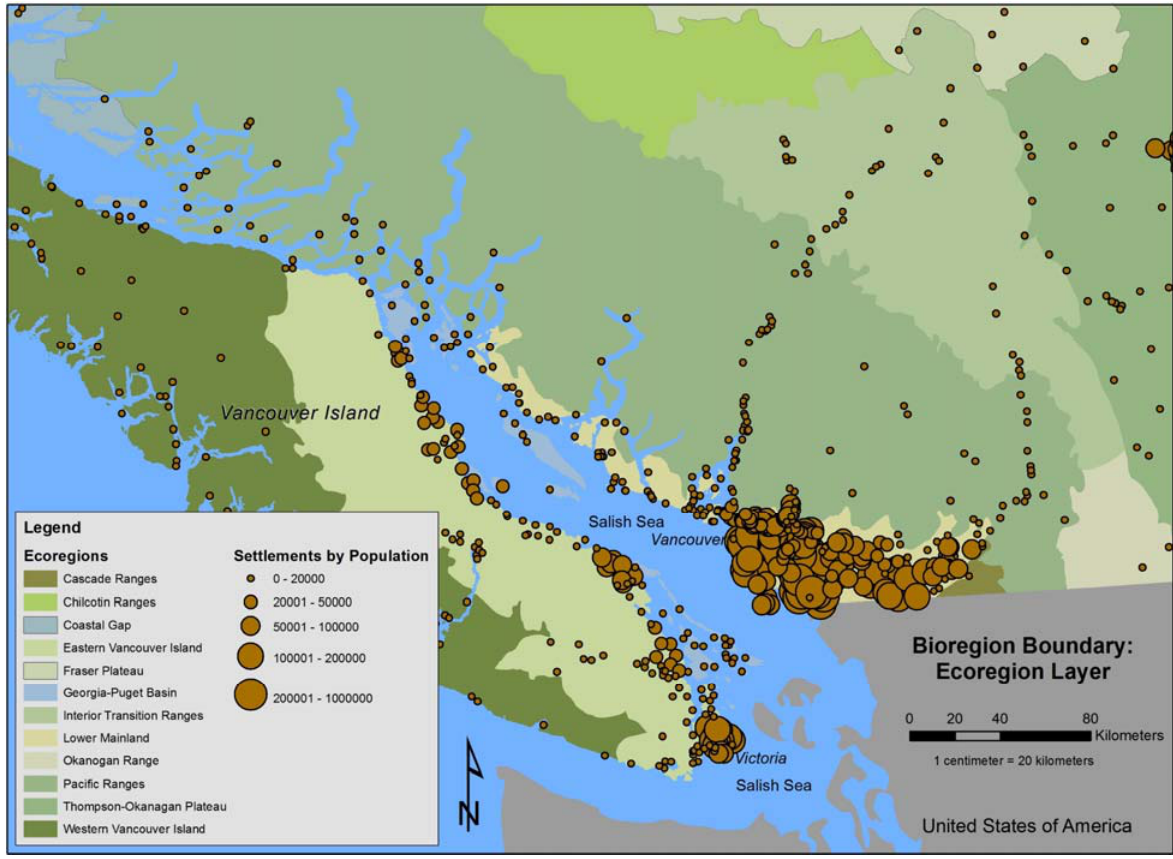
Figure 2. Ecoregions (Level 3 Classification). Ecoregions show areas with distinct ecological communities and also reflect similar climate, geology, and soil